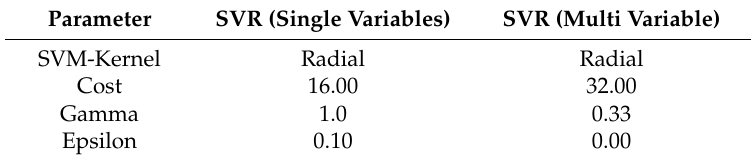
Table 5. Accuracy of SVR model and Persistence method (11 January 2016).